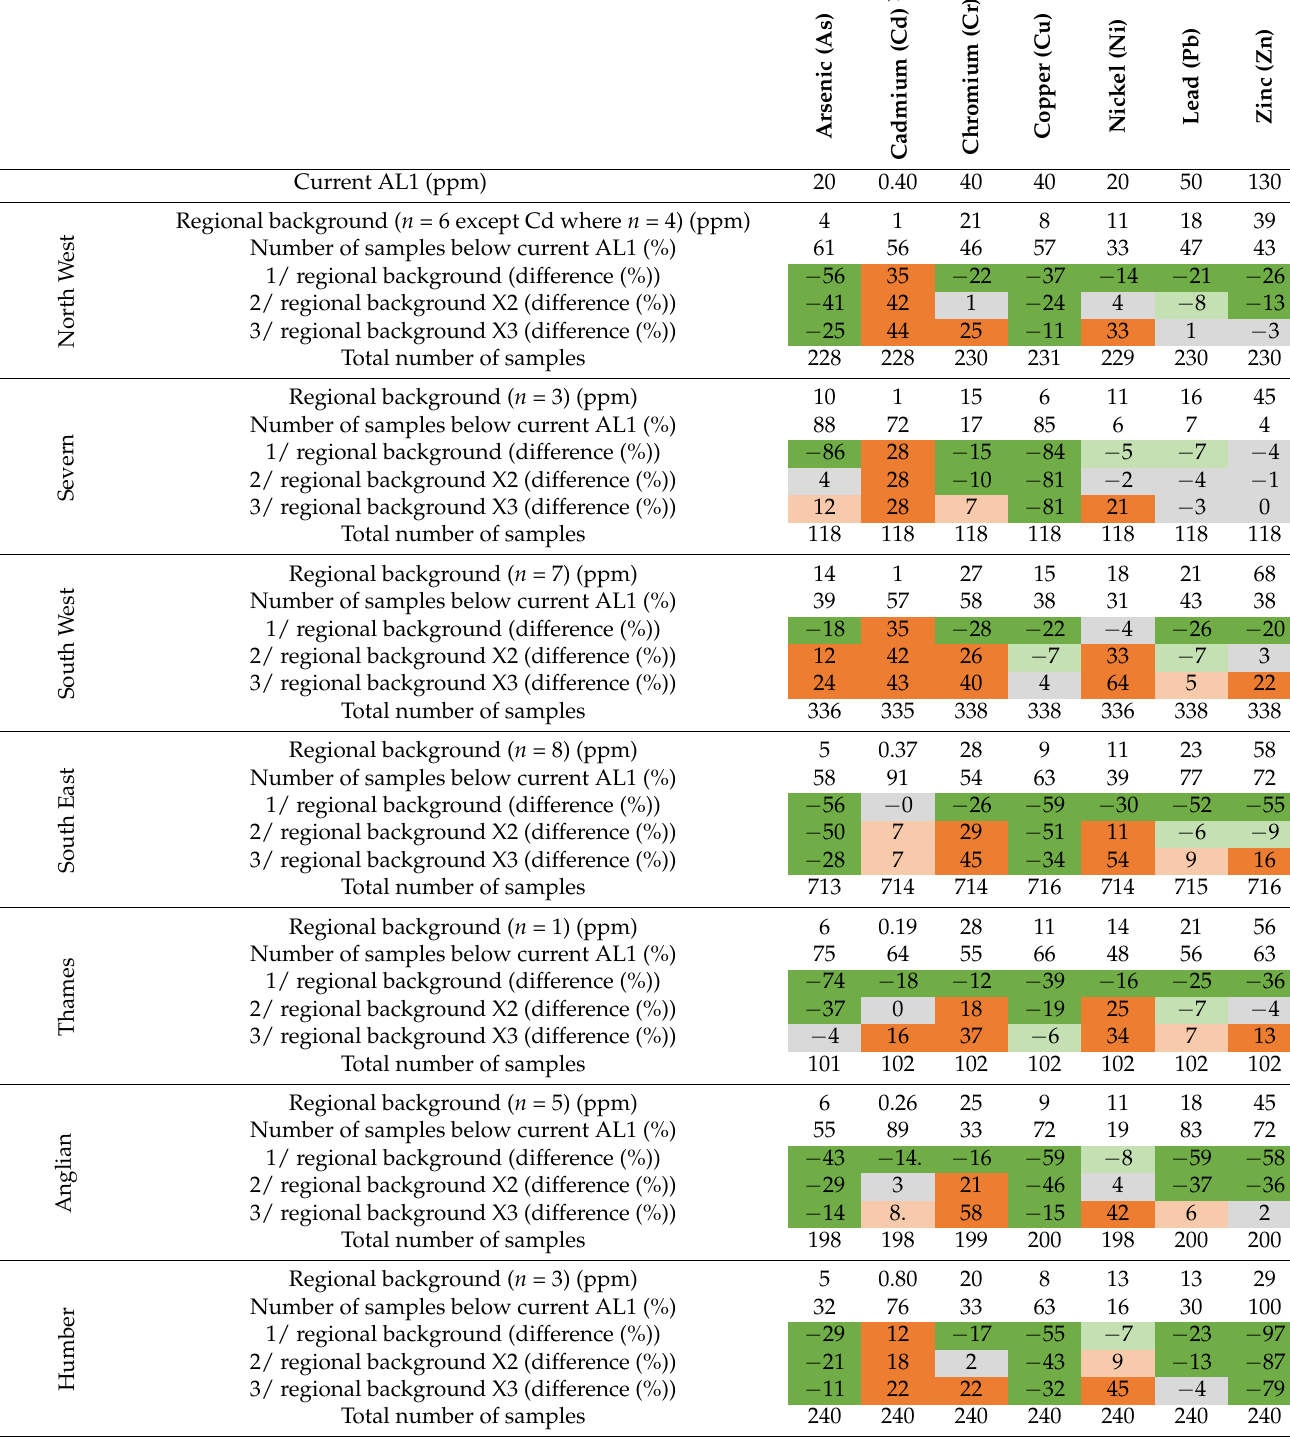
Table 7. Trace metals—Regional background, and differences in numbers of samples (%) below AL1 (current AL1 − regional AL1) when compared to the current AL1 for 1/ regional background; 2/ regional background X2; and 3/ regional background X3. Regions are in geographic order starting from the North West coast ending in Northumbria (Figure 5). The number of samples ( n ) that are averaged for each metal regional background are indicated. Please note values (green) are more protective and values (orange) are more permissive (colour codes defined in Table